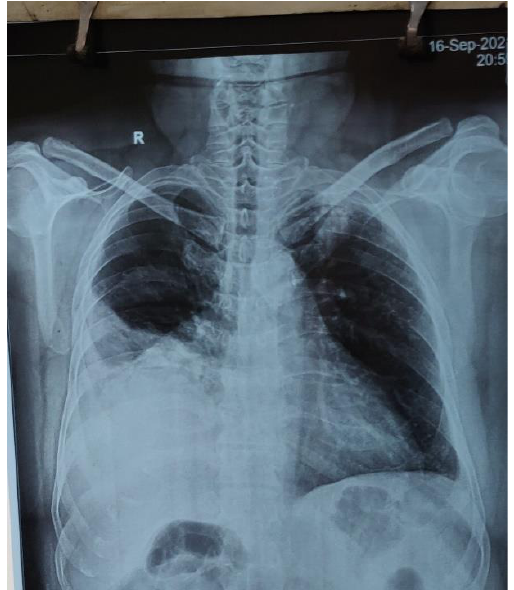
Figure1 . Chest x ray of patient showing right lower lobe collapse with effusion.